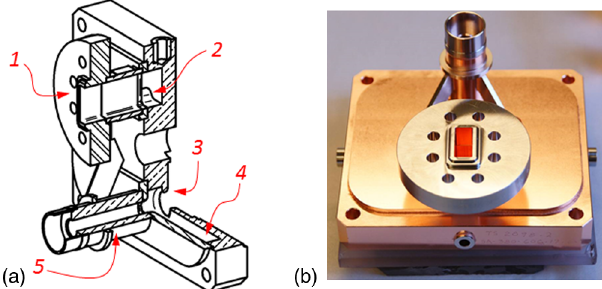
FIG. 3. Input part of the coupler assembly: (a) solid model of the assembly; (b) brazed assembly before joining to disk-loaded waveguide. In (a) are shown 1: input WR90 flange; 2: E-plane splitter; 3: input iris of the first matching cell; 4: H-plane miter bend; 5: extra long beam pipe.